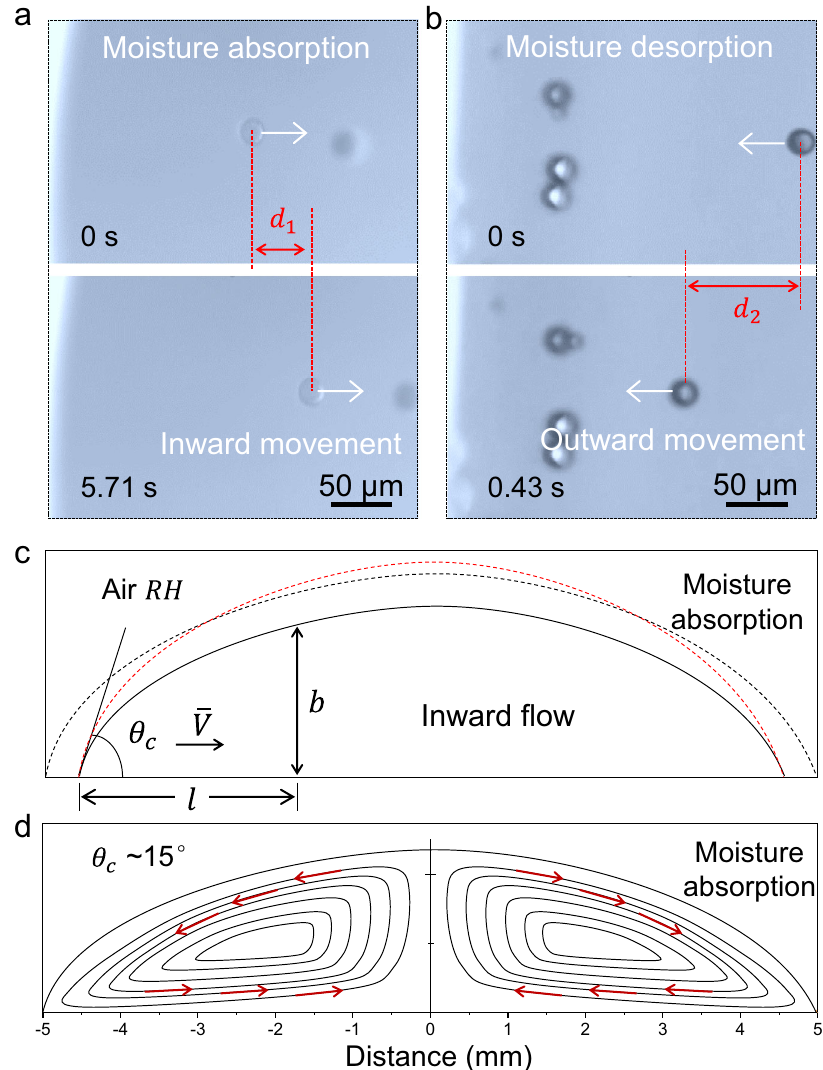
Fig. 3 Optical observation and theoretical calculation of the directional fl ow. a , b In situ microscope imaged polystyrene microspheres (diameter, ~18 μ m) added to dry/wet IL drop exposed to air (RH, ~40%) to con fi rm the inward fl ow and outward fl ow. c Schematic illustration and calculation of how moisture absorption could cause inward fl ow along the bottom of IL drops. d Schematic showing the moisture absorption induced complete fl ow within the outline of the drop recorded by microscope imaging (Supplementary Fig. 3a,